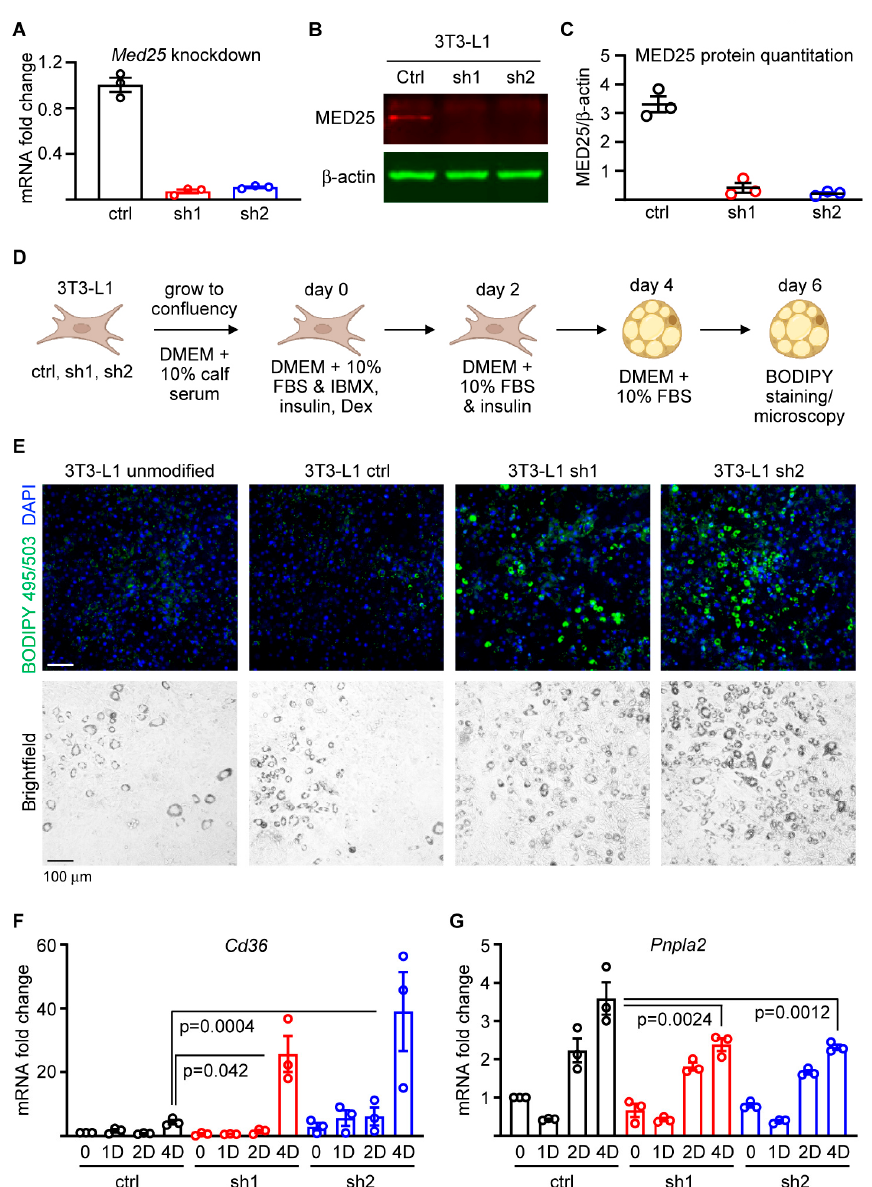
Figure 3. Med25 silencing enhances adipogenesis. ( A ) mRNA expression analysis validating Med25 expression knockdown relative to controls (ctrl–3T3-L1 infected with lentiviruses carrying blank vector) using two independent shRNAs (sh1 and sh2) that target Med25 . Fold-change was derived from the mean value of ctrl samples used as a relative reference. n = 3. Error bars = SEM. ( B ) Immunoblot of MED25 and β -actin in nuclear extracts from 3T3-L1 cells expressing sh1 and sh2. ( C ) Densitometry measurements of MED25 protein levels normalized to β -actin and represented in arbitrary units. n = 3. Error bars = SEM. ( D ) Adipocyte differentiation schema using the ctrl and two (sh1, sh2) Med25 KD cells. Dex denotes dexamethasone. ( E ) BODIPY 495/503 and DAPI staining on 3T3-L1 cells differentiated into adipocytes for 6 days. Bright-field image is also shown to reveal lipid-filled, differentiated adipocytes. Representative images from three independent differentiation experiments are shown. Scale bar = 100 µ m. ( F , G ) qPCR analyses of Cd36 ( F ) and Pnpla2 ( G ) at undifferentiated (0), 1 day (1D), 2 days (2D), and 4 days (4D) post initiation of adipogenic differentiation. p values were derived using one-way ANOVA with Tukey’s post hoc. Fold-change values were derived by setting the ctrl 0 h sample value for each respective set as “1”. n = 3. Error bars =